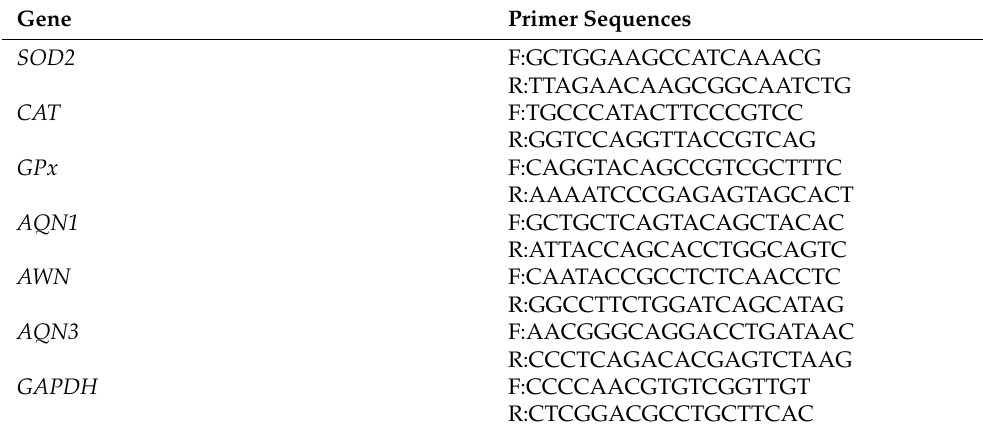
Table 1. List of primer sequences used in real-time PCR